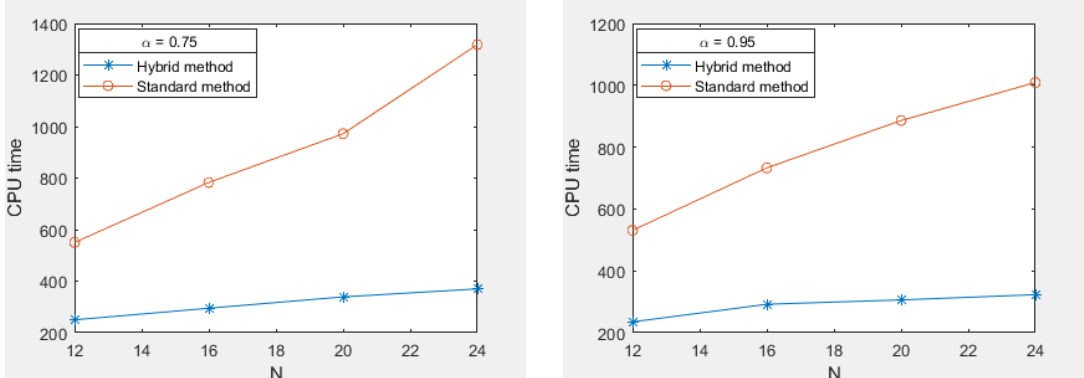
Figure 2. CPU time versus total number of time levels 𝑁 of Example